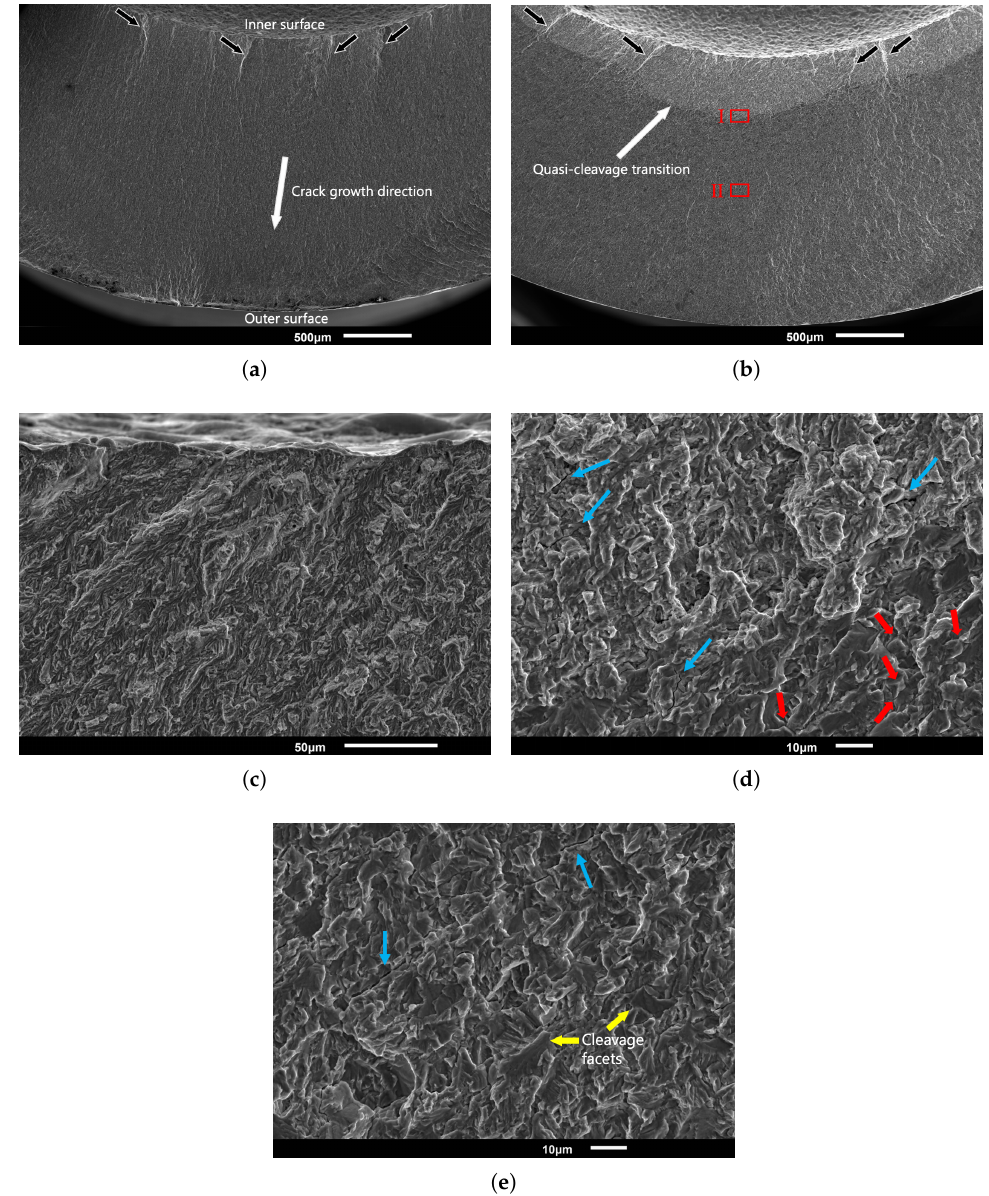
Figure 7. SEM fractographic images of notched base metal samples. ( a ) Macroscopic overview of a 150 barg N 2 and ( b ) a 150 barg H 2 tested sample. The black arrows indicate ratchet marks. ( c ) Zoomed-in view of the notch of a 150 barg H 2 tested sample. ( d ) Higher magnification view of Area I in ( b ) showing the quasi-cleavage transition. ( e ) Higher magnification view of Area II in ( b ) in which cleavage facets are clearly visible. The blue and red arrows indicate secondary cracking and triple points,